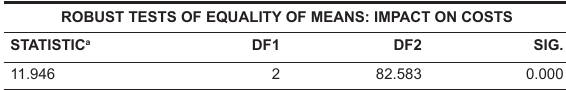
TABLE 16 Robust tests of equality of means